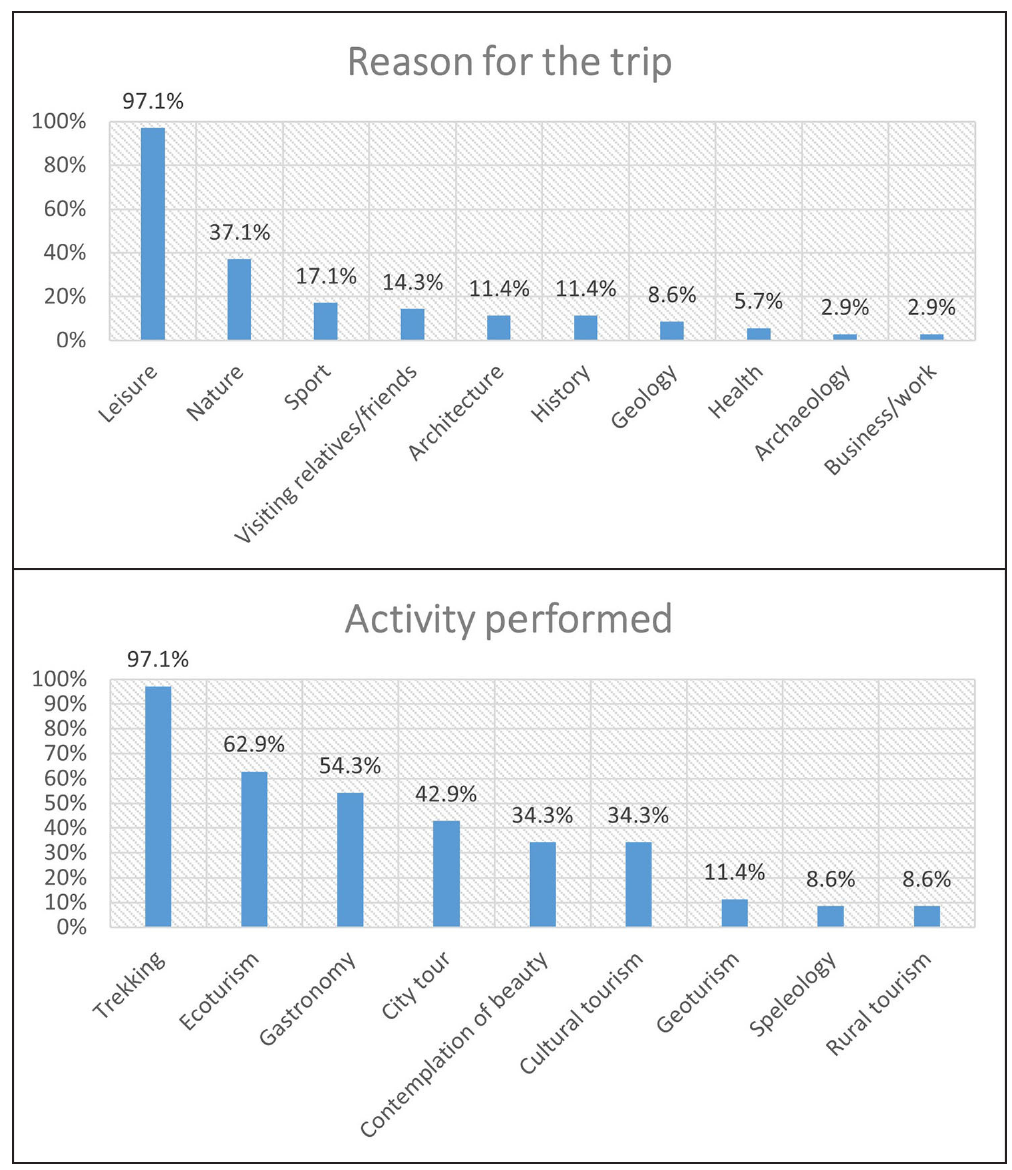
FIGURE 3. Reason for travel and activities carried out by tourists with a strong affinity for the practice of geotourism in the territory of the Serra do Sincorá Geopark Project, Lençóis, Bahia.